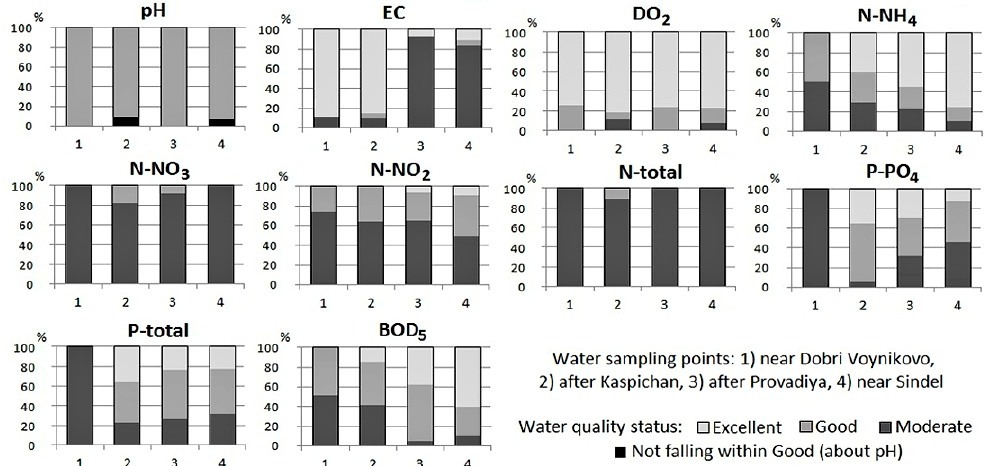
Figure 2. Frequency (% of all samples) of water quality variables in a certain status according to the reference values stated in Regulation H-4/2012 for characterization of the surface